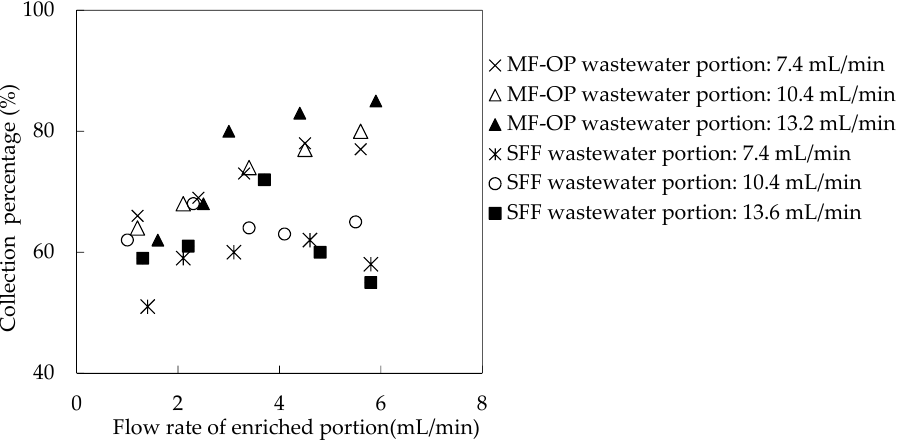
Figure 5. The comparison between MF-OP and traditional SLM for current speeds influence on collection of Ho(III) in both portions (II).